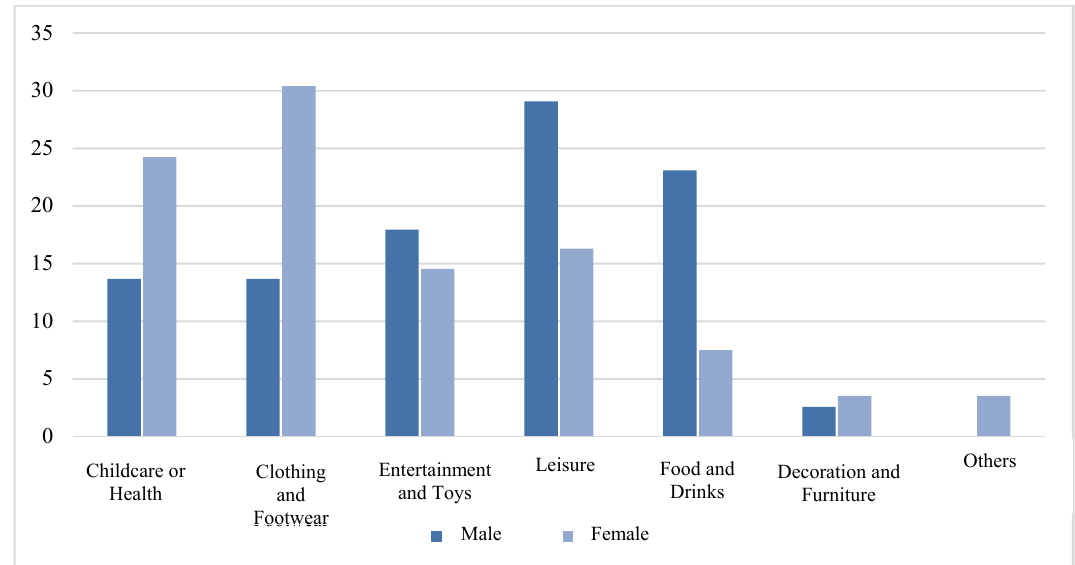
Figure 7. Categories of disclosed brands by gender (%).